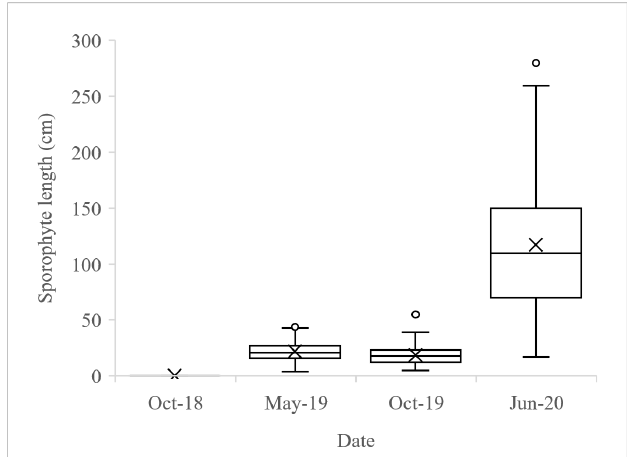
FIGURE 8 Sporophyte lengths on the 100 m long cultivation net (n=150). Box plots are calculated including the median, the median is marked with a line, the average with a cross and the max/min with whiskers in top/ bottom of each box.